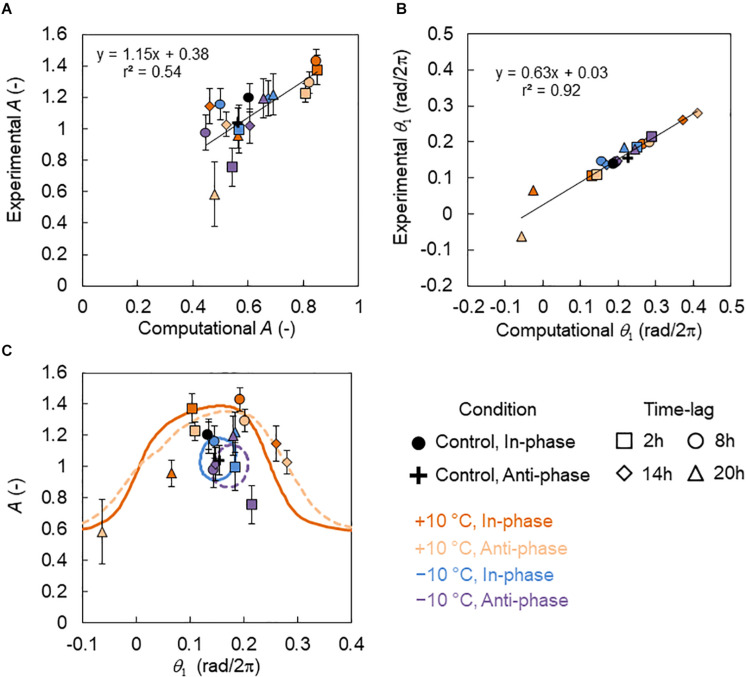
Relationship between the amplitude and locking phase of the CCA1 rhythms in the experiments and simulations. (A) Correlation between amplitudes A in the experiment and simulation (mean ± SD in experiment). (B) Correlation between the locking phase θ1 in the experiment and the simulation (circular mean in experiment). The black lines indicate regression lines. (C) Relationship between A (mean ± SD) and θ1 (circular mean). The symbols indicate the experimental data points. The colored lines indicate the relationship between A and θ1 in the simulation. The solid lines indicate the in-phase conditions and the broken lines indicate the antiphase conditions. The simulation values of A and θ1 were calibrated using the regression lines in (A) and (B) as Acalibrated = 1.15A + 0.38 and θ1,calibrated = 0.63θ1 + 0.03.